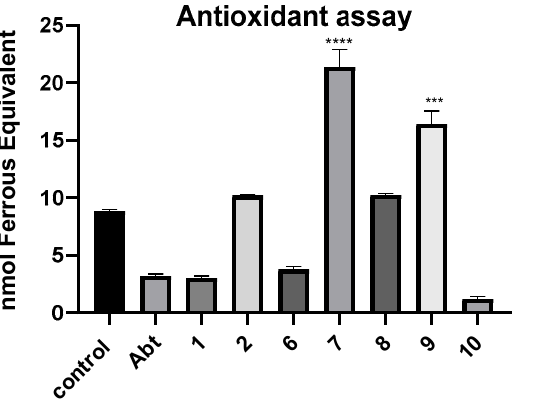
Figure 5. Antioxidant capacity evaluation via FRAP. Compounds were evaluated for antioxidant capacity at 100 µ M (Abt = dehydroabietylamine). Values are expressed as mean ± SE ( n = 3). Error bars indicate standard errors between control and individual compounds 7 and 9 , respectively, *** p < 0.001, **** p <